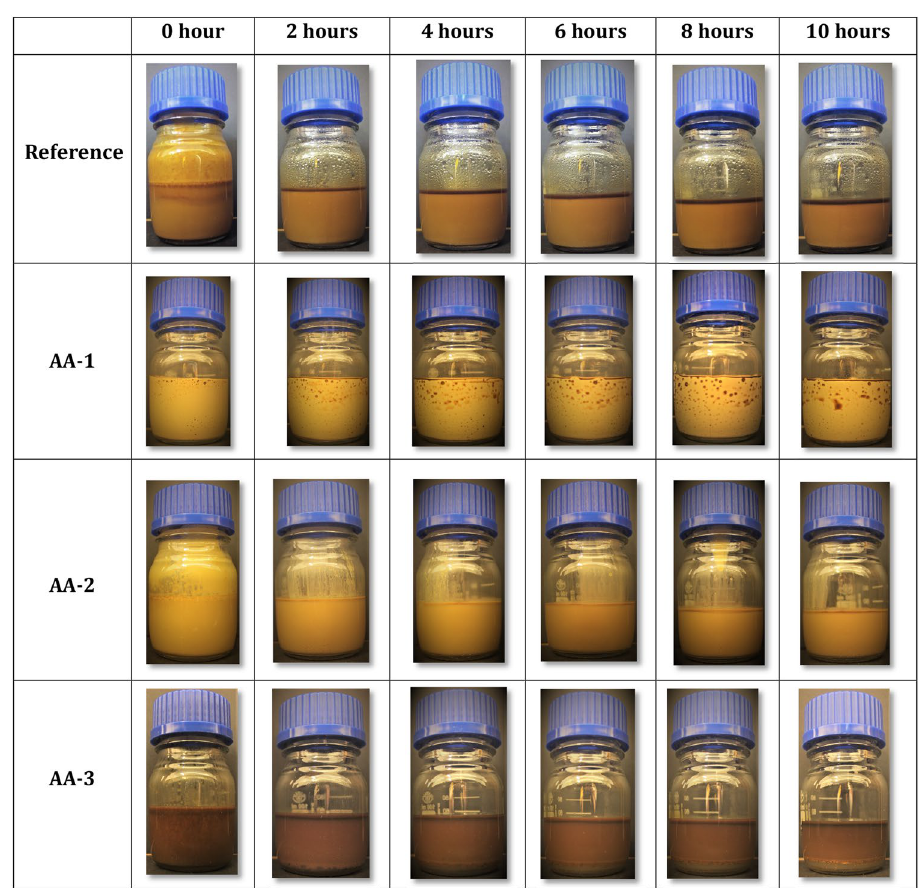
Fig. 6 Photographs for emul- sion in 10-hour observation for the reference (blank) sample and with the presence of AA-1, AA-2 and